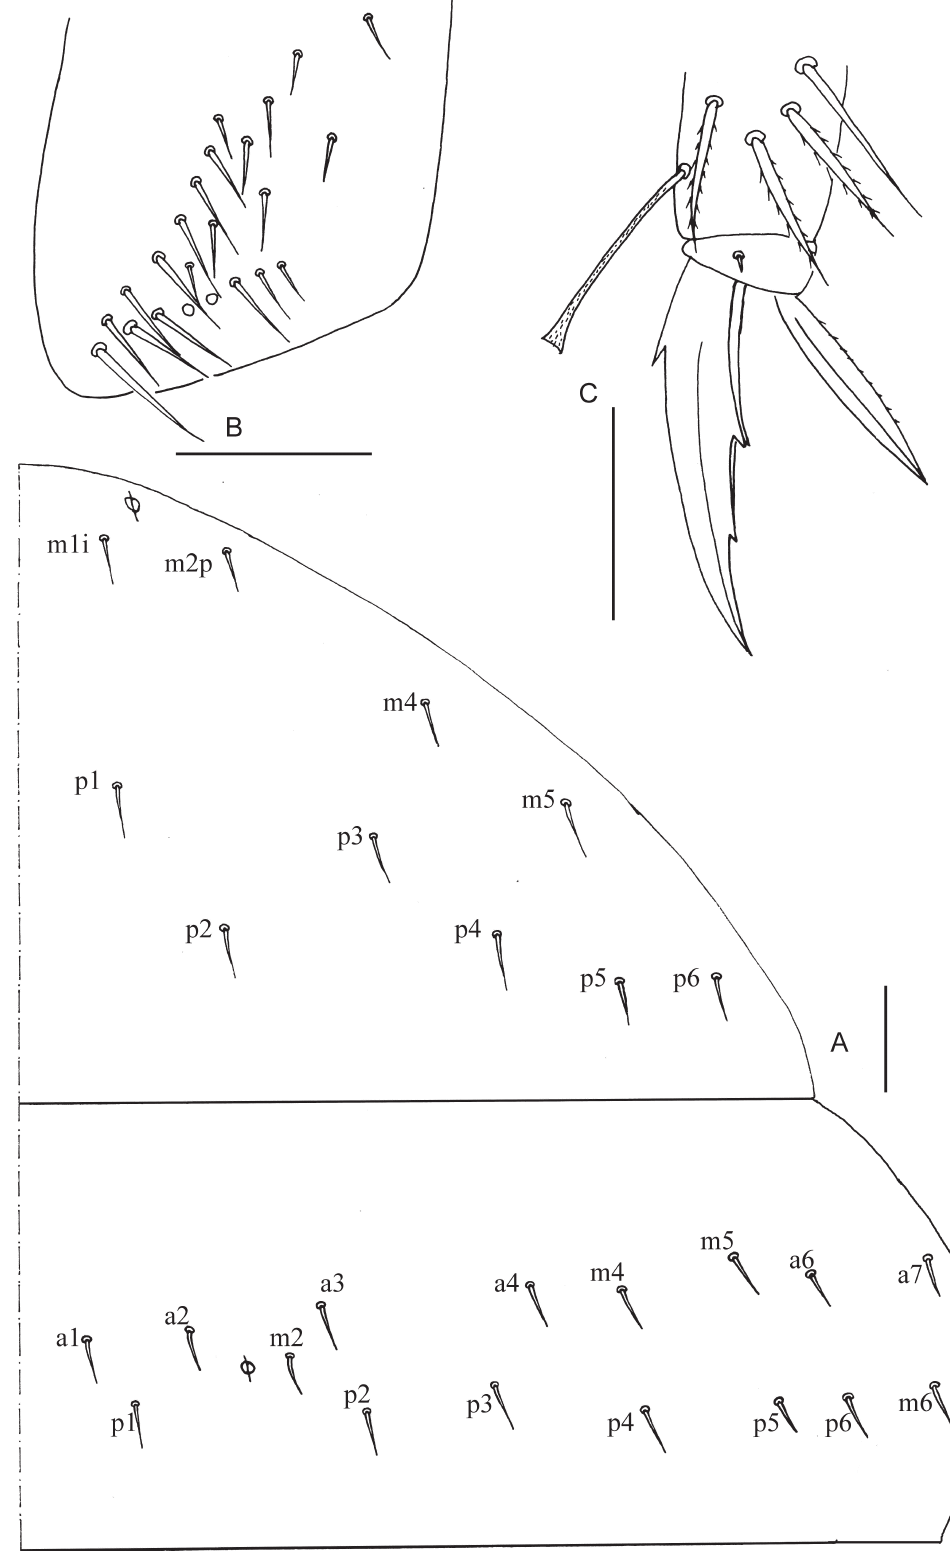
Fig. 4. Lepidocyrtus ( A. ) huizhouensis sp. nov. A . Chaetotaxy of Th. II−III (right side). B . Trochanteral organ. C . Hind foot complex (anterior view). Scale bars: 30